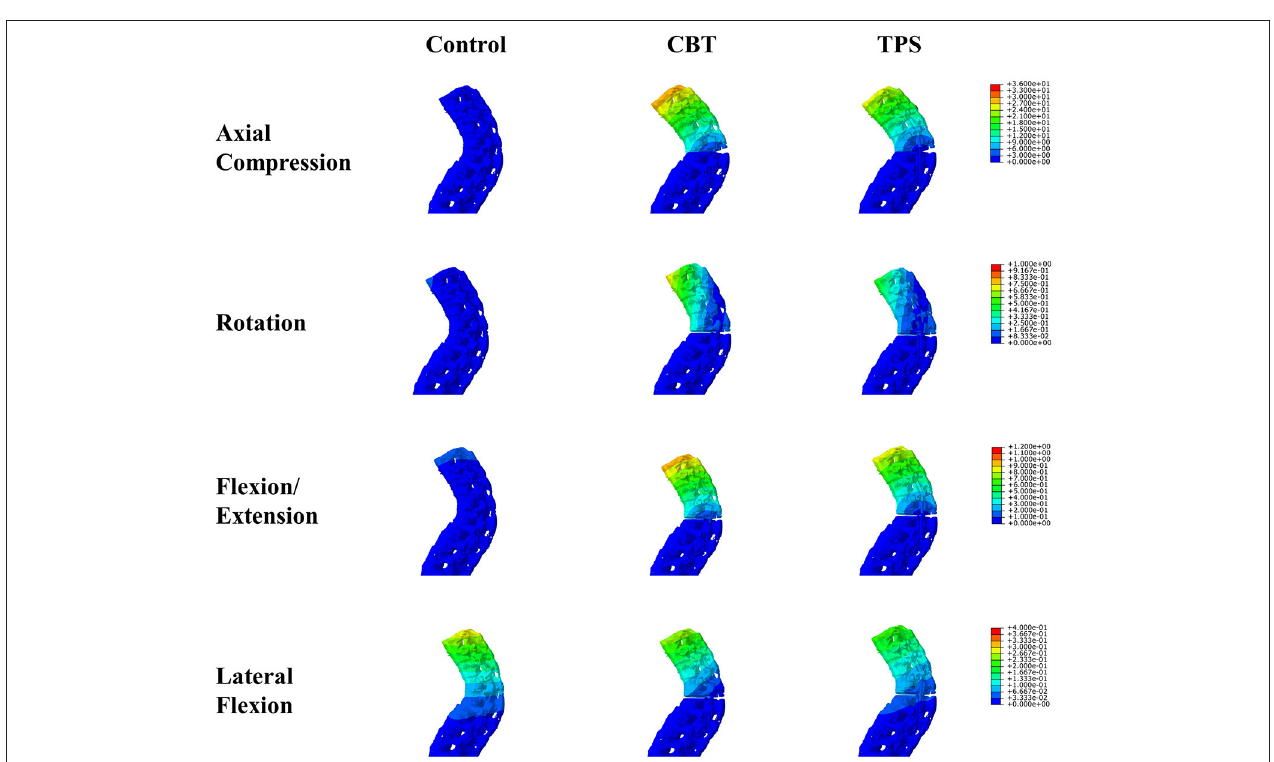
FIGURE 2 | Spinal displacements under axial compression, rotation, flexion/extension, and lateral flexion